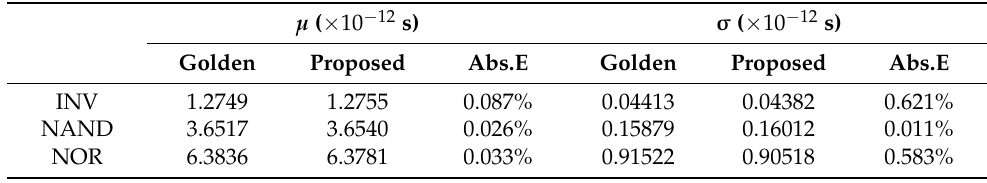
Table 4. The statistical accuracy of SGDE framework.